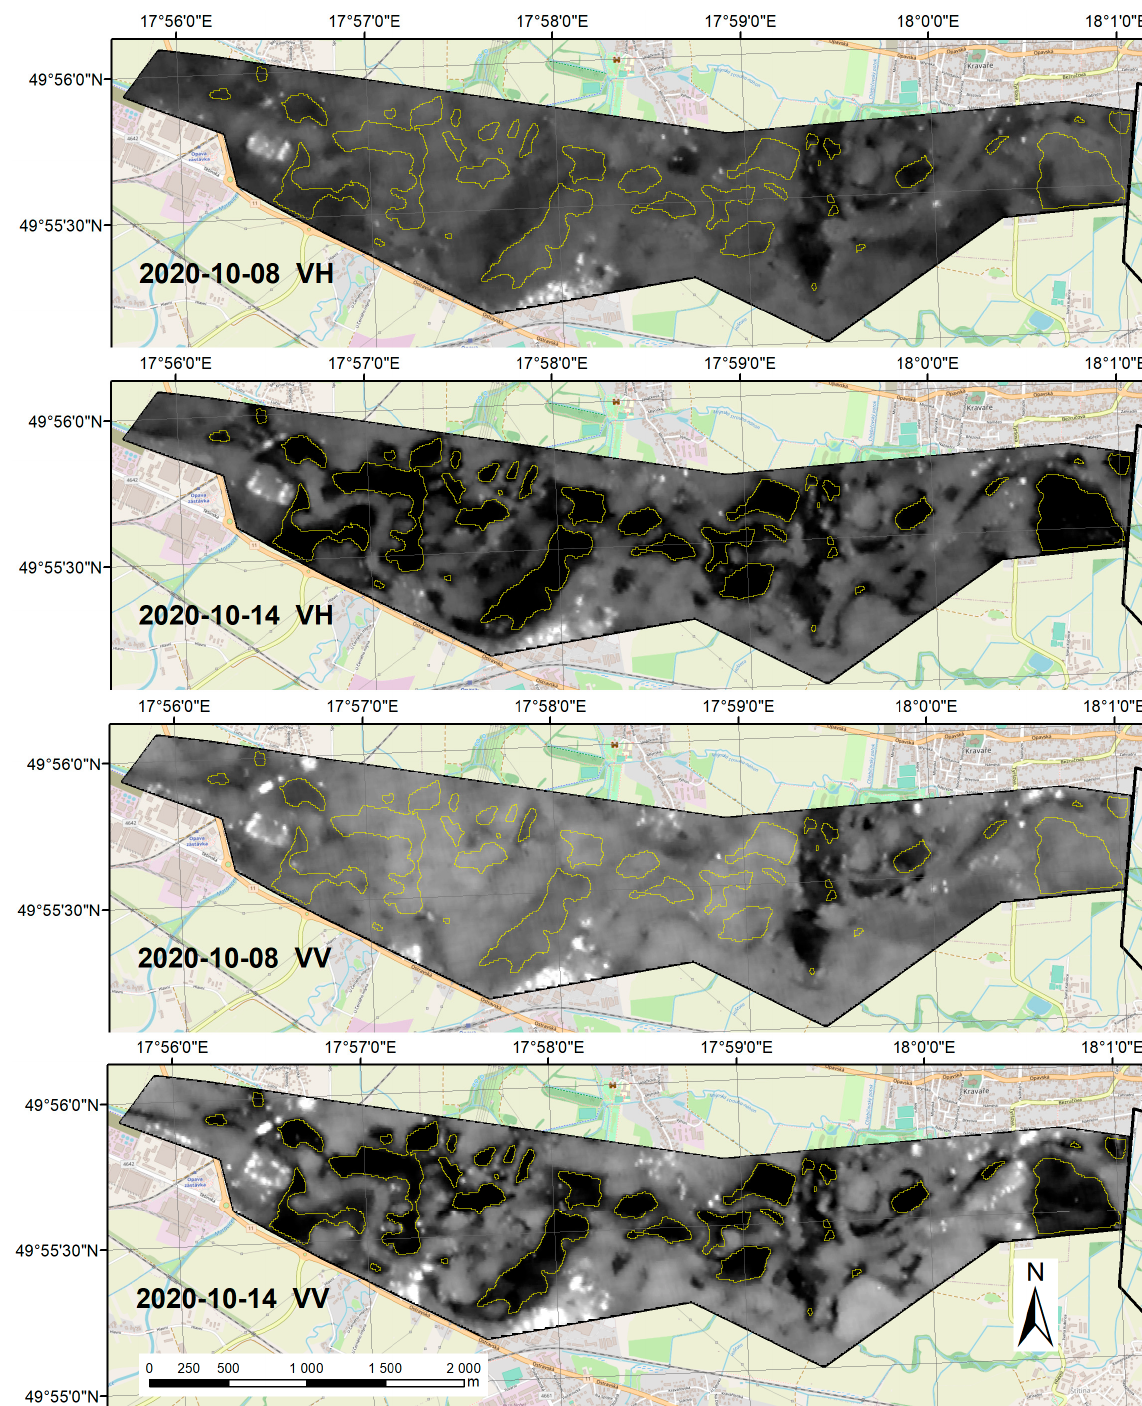
Figure 15. Sentinel-1 imagery from track A73 acquired during the flood event (14 October 2020) and before the flood event (8 October 2020) in sub-area 1 (see Figure 14). Dates of image acquisition and data polarization is printed in each figure. The symbology is different for different data polarizations, black corresponds to − 26/ − 20 dB (VH/VV) or lower, and white colour corresponds to +2/+1 dB (VH/VV) or higher. Areas identified as flooded by the developed solution from the Sentinel-1 data for 14 October 2020 are shown in yellow in all the figures. Source of background map: Open Street Map